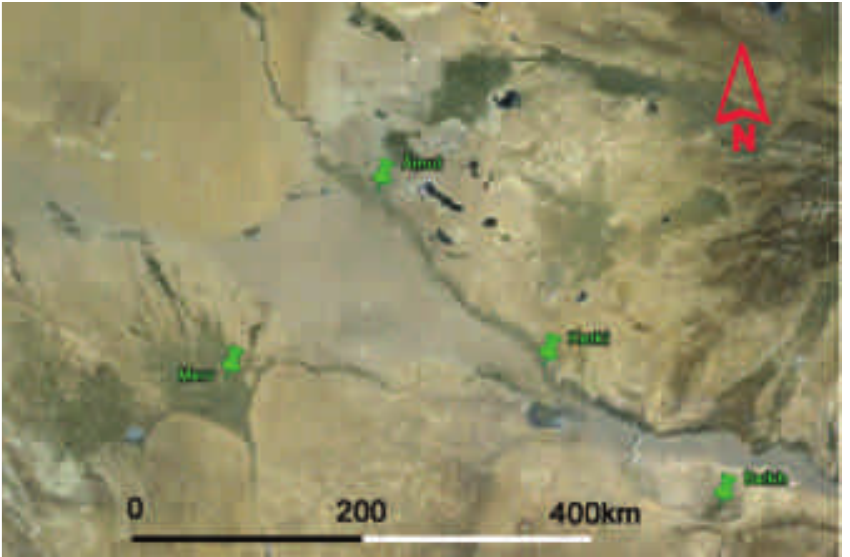
Figure 1 Satellite image of the region showing the fertile Murghab delta, the location of cities of Merv, and Āmul, on banks of the Amu Darya River (Oxus), some 200 km away. Note the intervening desert landscape. (Background © Google EarthTM mapping